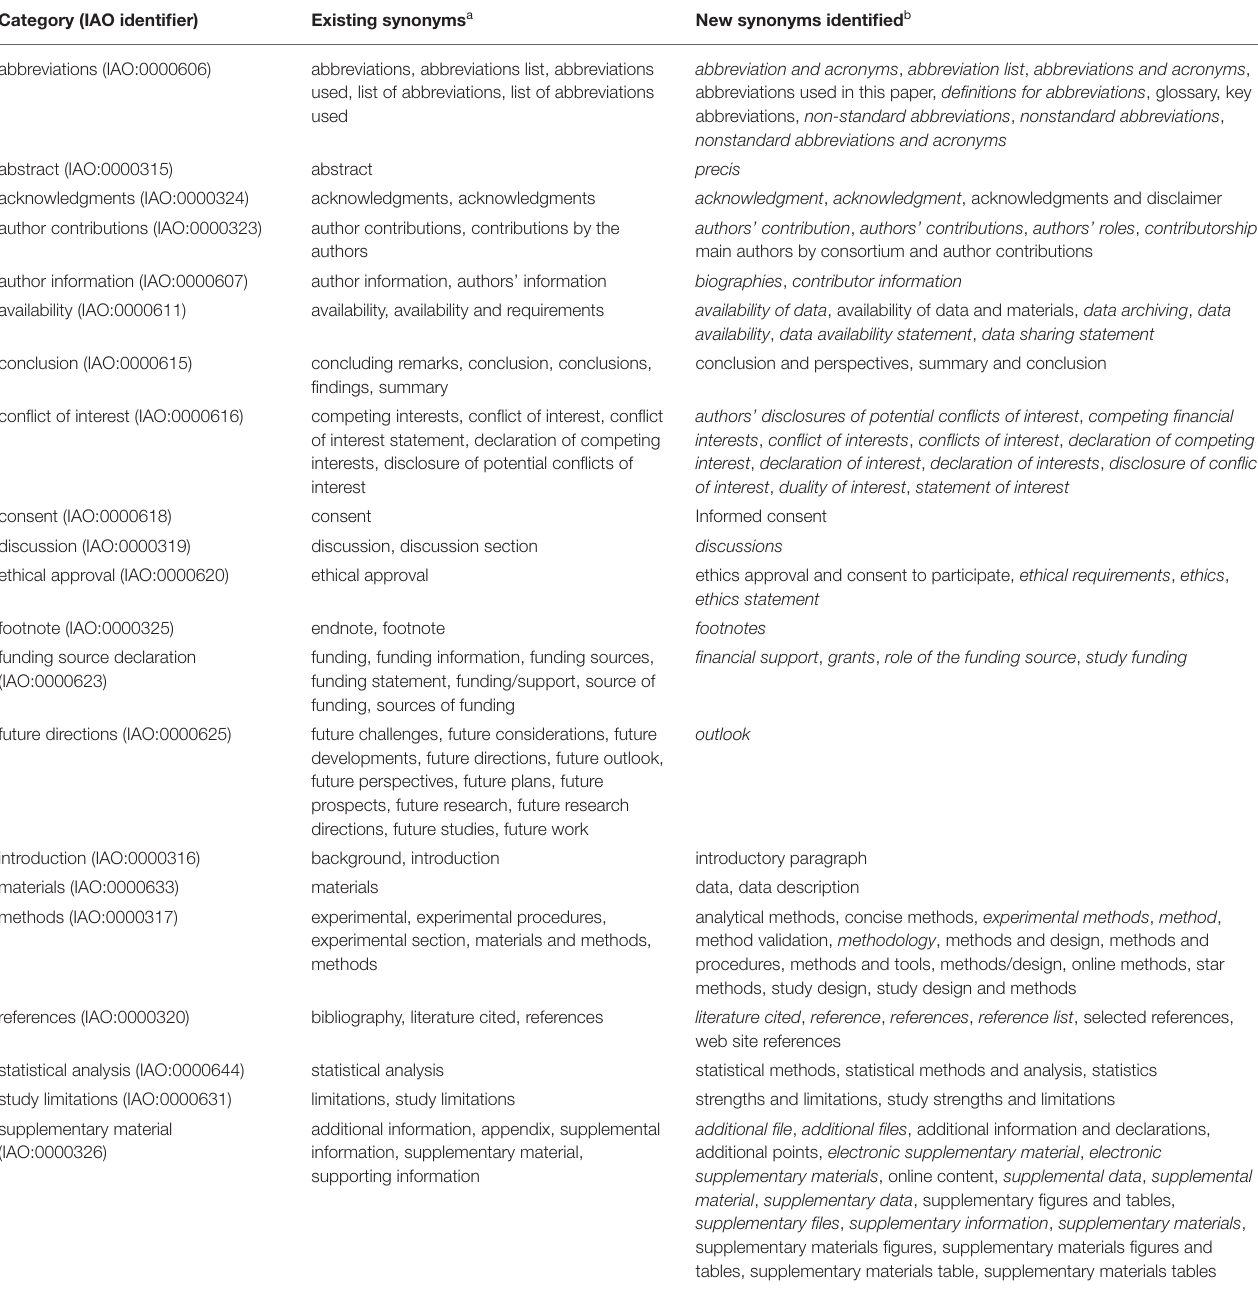
TABLE 2 | New synonyms identified for existing IAO terms from the fuzzy and digraph mappings of 2,441